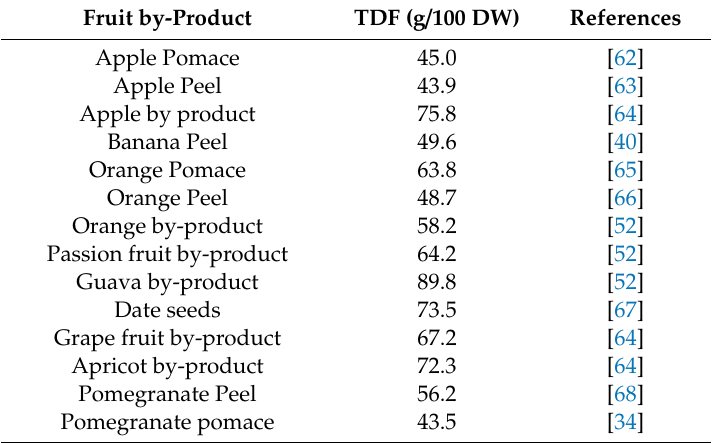
Table 2. Dietary fibre content in some fruit by-products. Fruit